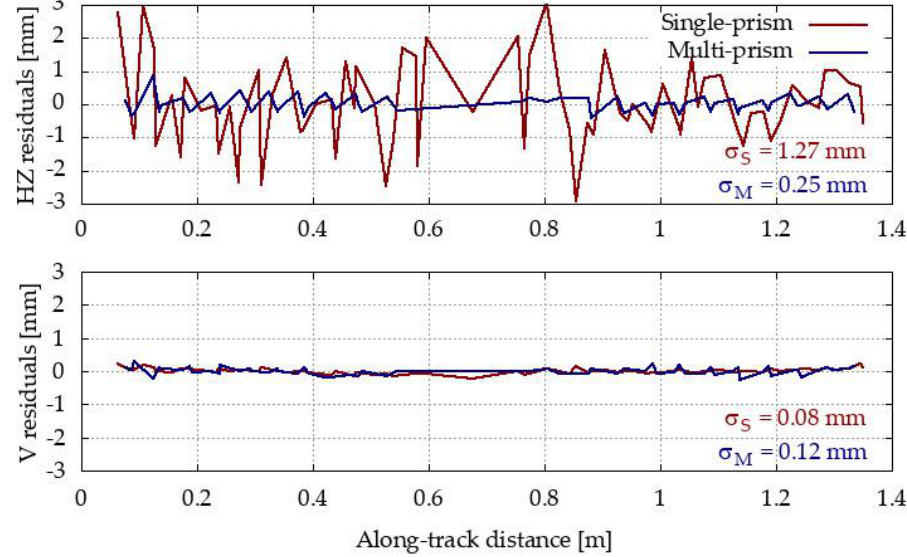
Figure 9. Residuals of the measured values from the adjusted line for the compared methods.